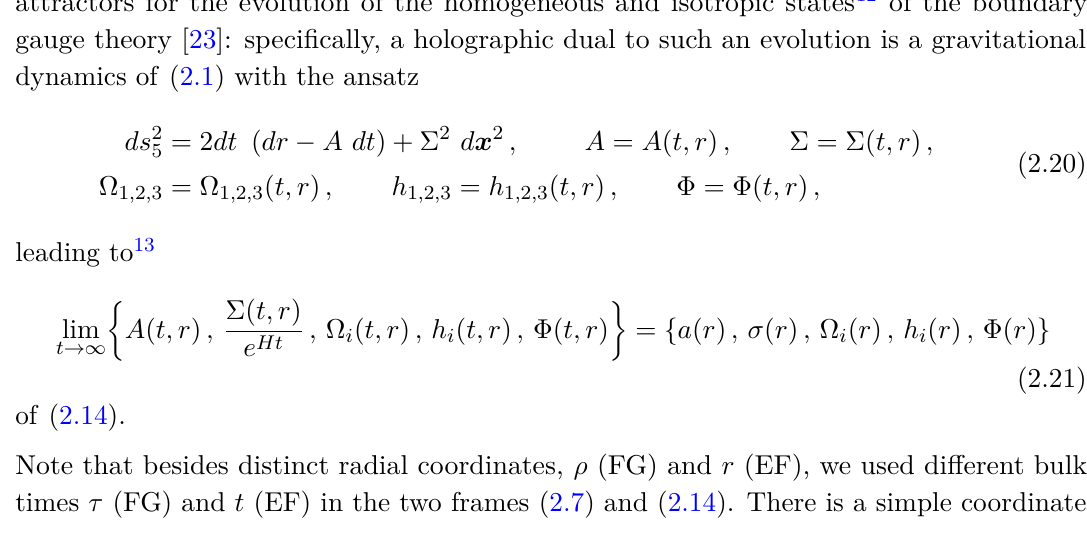
), as a function b